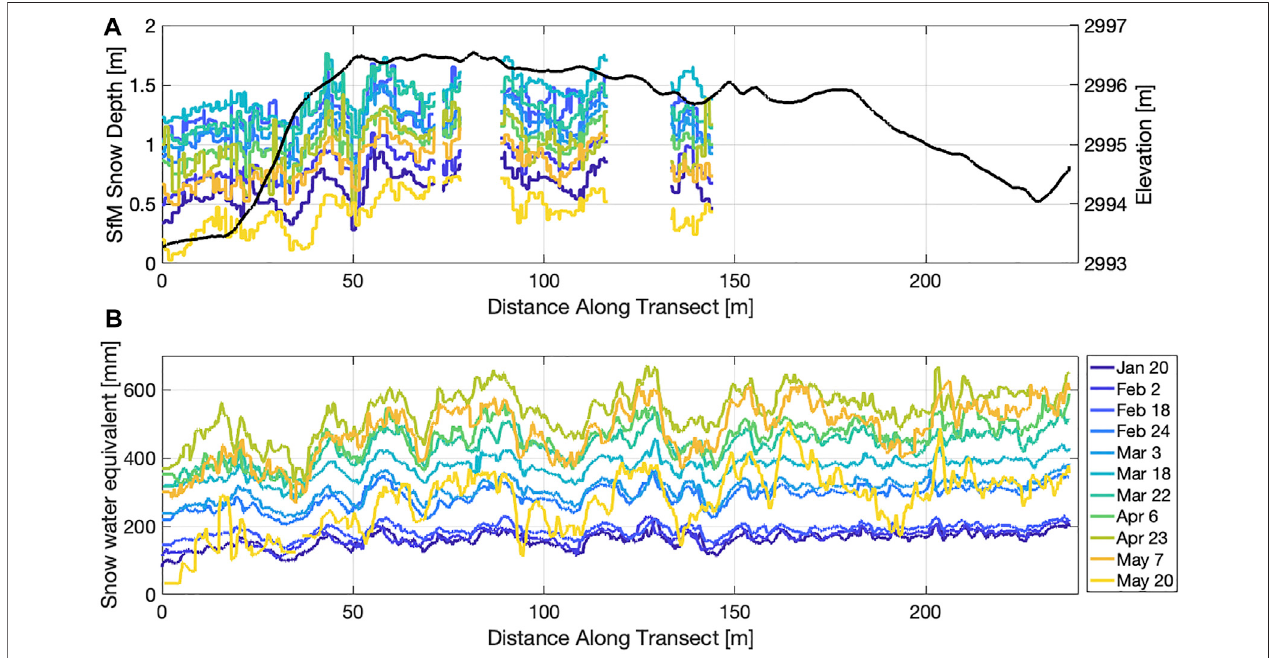
FIGURE7|(A) SfM-derivedsnowdepthsalongtheGPR-probetransect.Thelegendinbisapplicabletothisplot.Thesnow-offsurfaceelevationisshowninblack. (B) Snow water equivalent along the GPR transect for the eleven survey